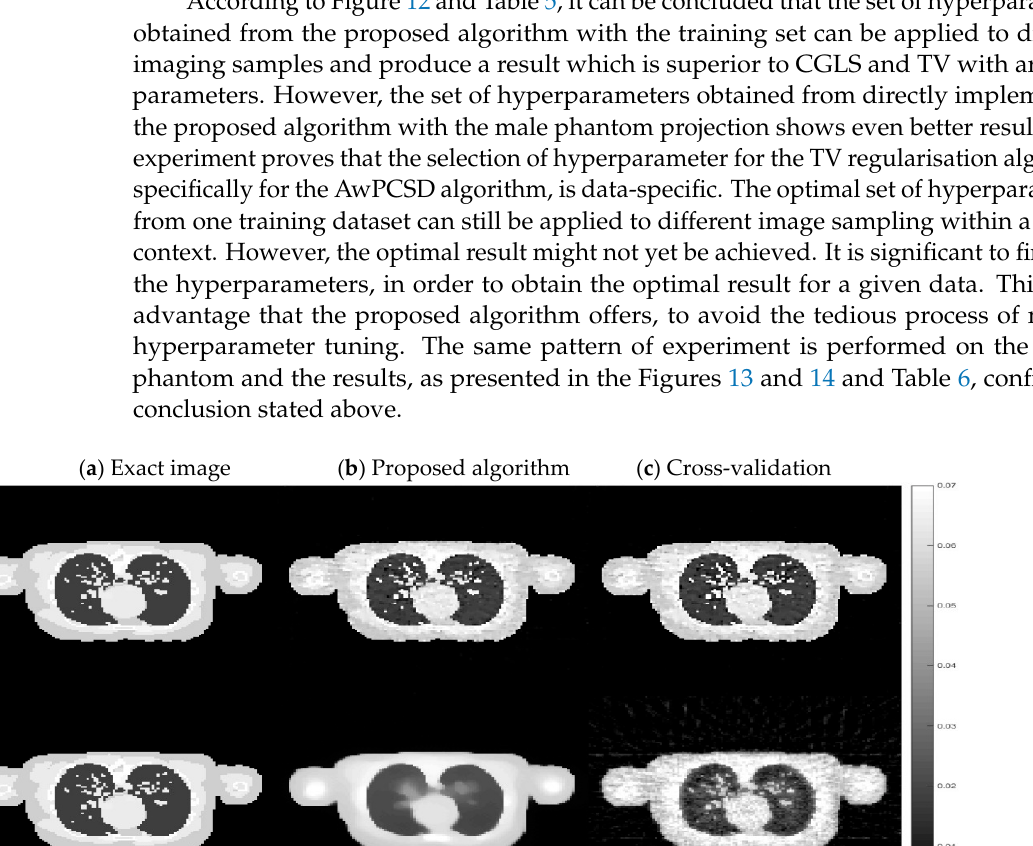
19 of 22 Table 5. Relative errors and UQI of image reconstruction results from the male phantom using each set of hyperparameters and the CGLS algorithm [15].